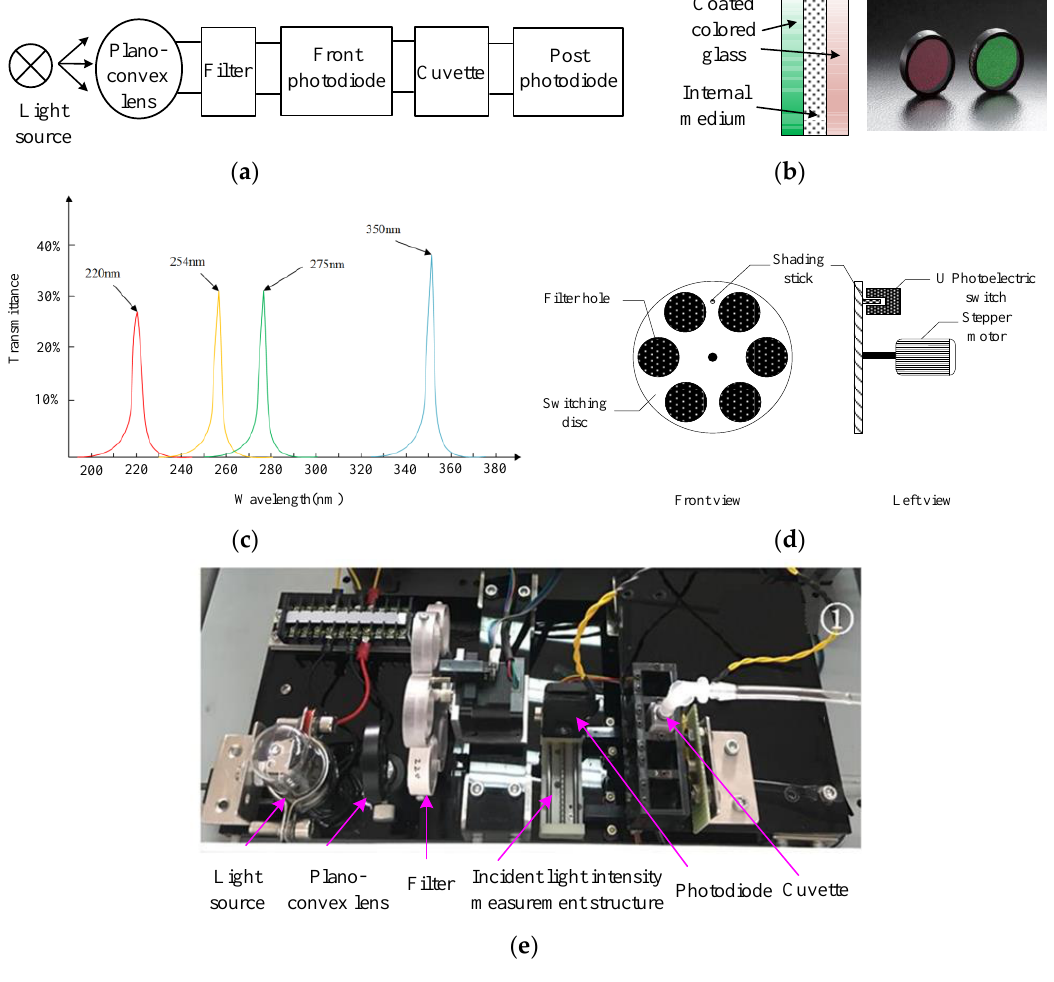
Figure 7. Optical detector unit ( a ) block diagram; ( b ) photograph; ( c ) Filter; ( d ) Filter transmission spectrum; and, ( e ) Automatic switching filter structure diagram.